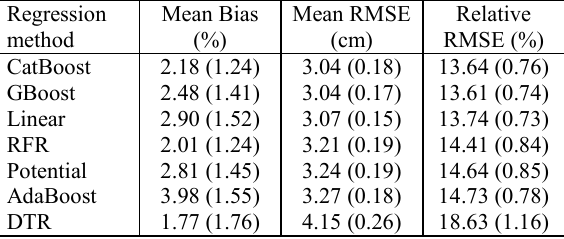
Table 4 . Statistics of systematic and random error for multivariate allometric models DBH = Φ(H, CD). Figures in parentheses correspond to the standard deviation.